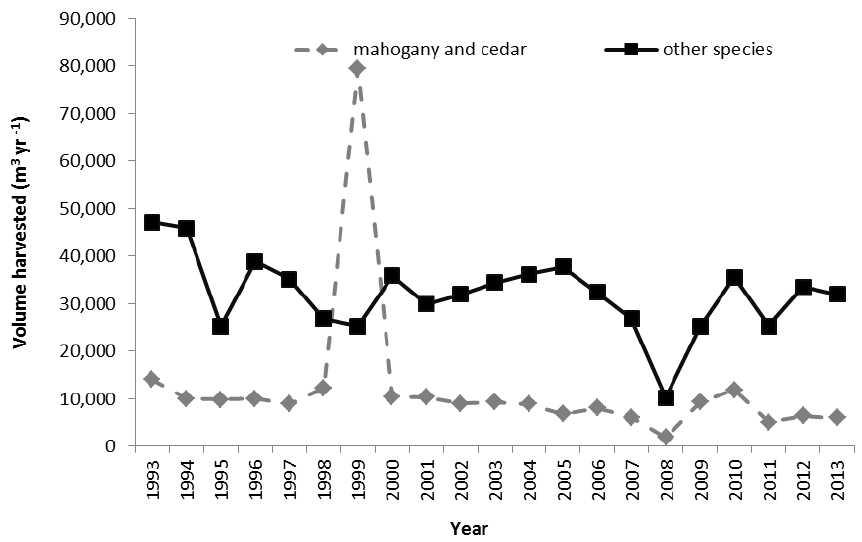
Figure 2. Annual commercial timber harvest in Quintana Roo, Mexico. Timber volumes include all wood uses, such as sawtimber, pulp, veneer, polewood, firewood and charcoal, but excludes railroad ties up to 1995 [79]. The 1999 spike in mahogany and cedar harvest volumes is consistent with other official data, but remains unexplained in these sources. The dip in 2008 is attributed to Hurricane